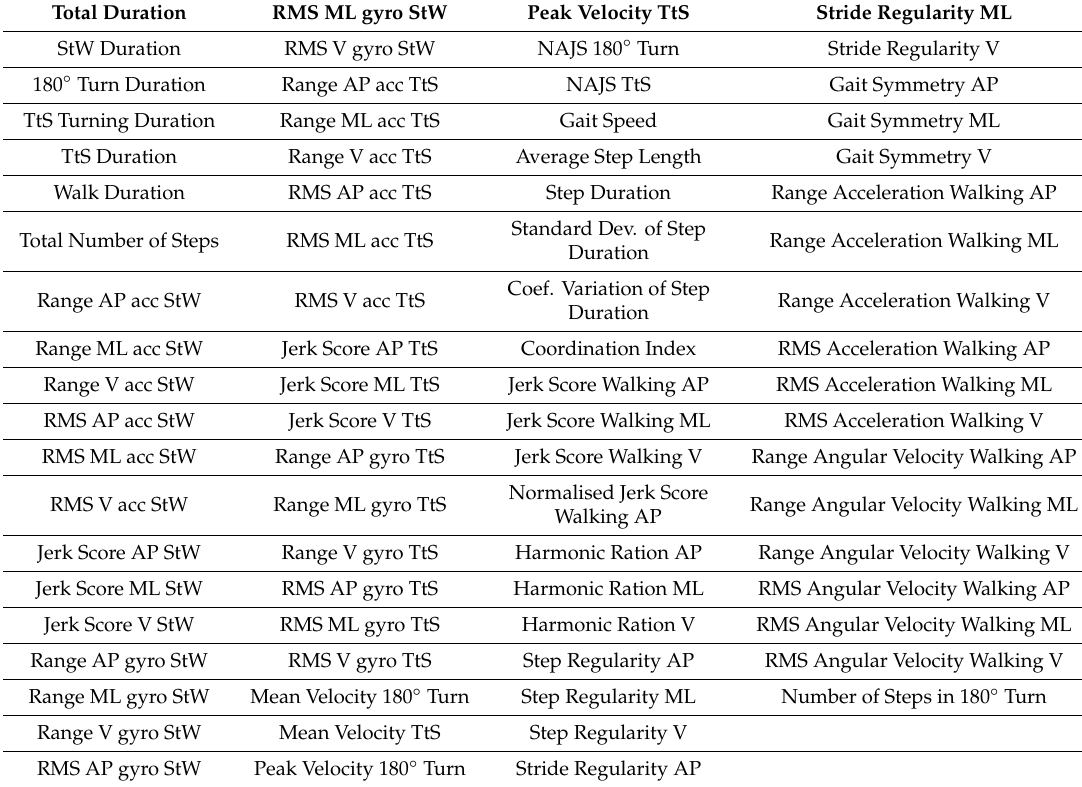
Table A2. Complete list of extracted iTUG features used in the PLSR